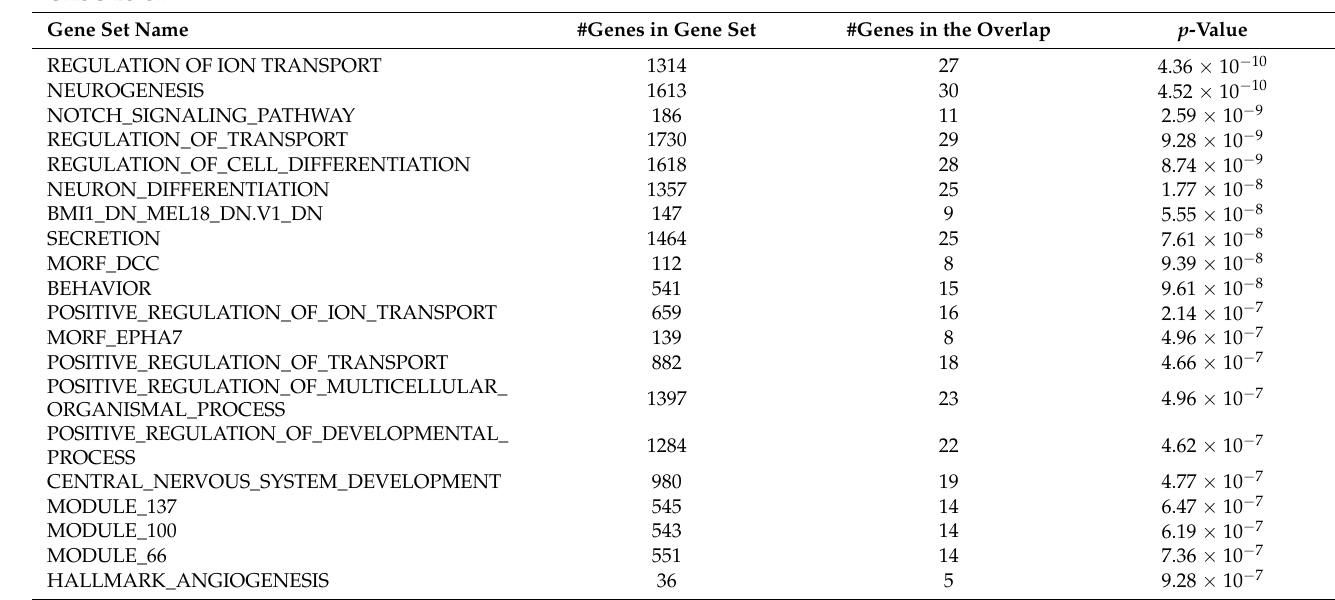
(greater than 2, red dots, or less than 2, green dots) on the x -axis versus their statistical significance ( p ≤ 0.05). For most of the genes in the array, we did not find any statistically significant difference. However, four genes resulted in significantly down-regulated (green dots in the upper left side of the graph) in GASC-LS: ALPL (Alkaline Phosphatase), GPR68 (G protein-coupled receptor 68), NETO1 (neuropilin and tolloid-like 1), and VGF (or VGF nerve growth factor inducible), (Table 3). Table 1. The Top 20 significantly enriched MSigDB pathways associated with the specific lists of genes up-regulated in GASC-LS. The table reports the overall number (#) of genes involved in the annotated pathways, the number (#) of genes provided as input, and the associated p -value.